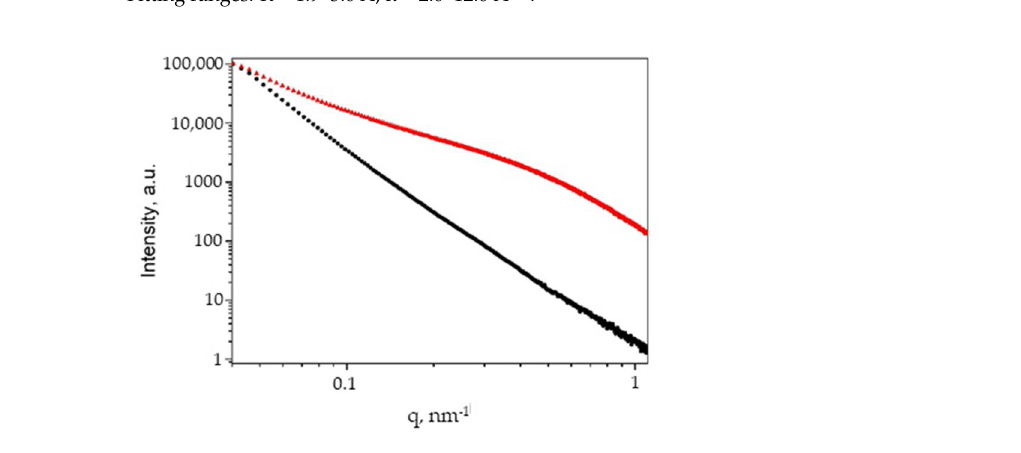
Table 3. Parameters of local environment of silver atoms in Ag-cellulose composites according to EXAFS data.